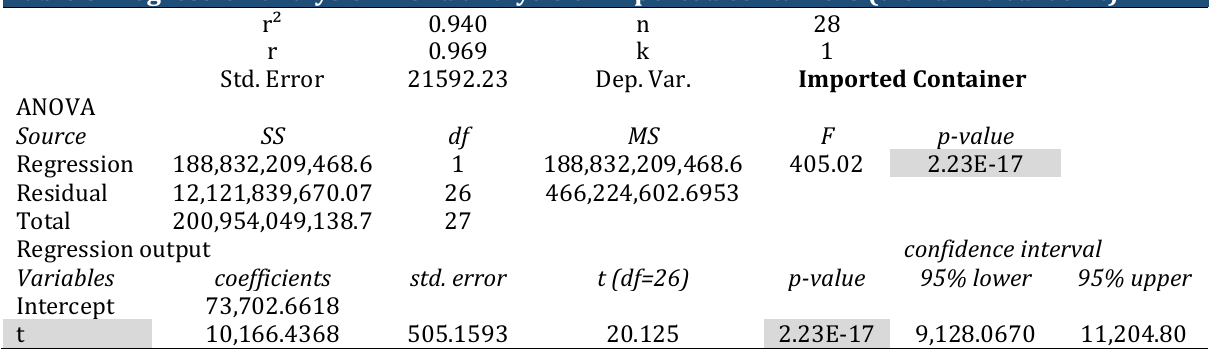
Table 3: Regression analysis: Trend analysis of imported containers (trendline curve fit) r²